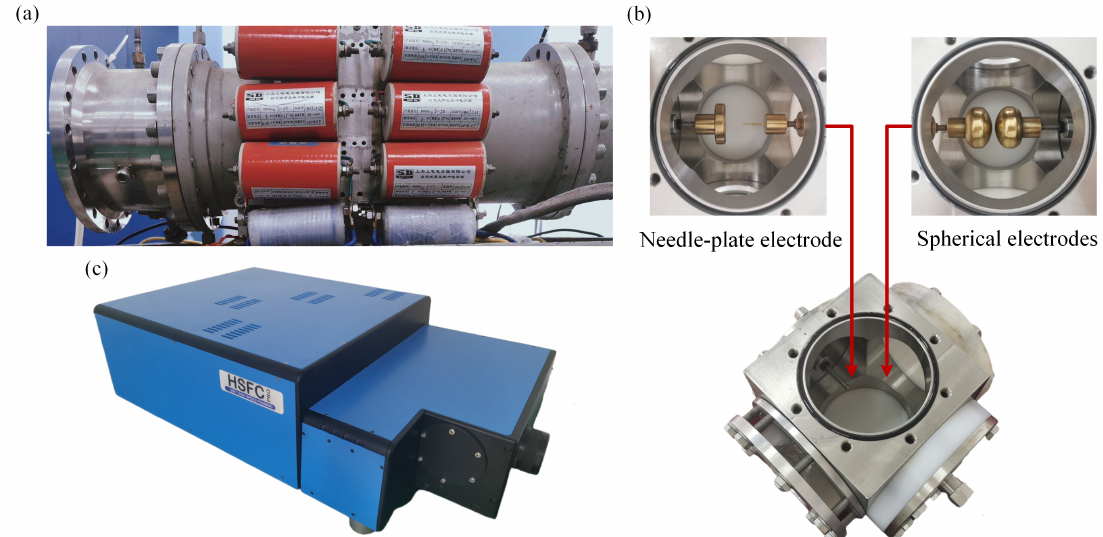
Figure 1. Experimental equipments of the microsecond-pulse breakdown strength test platforms: ( a ) microsecond pulse generator, ( b ) breakdown test cell, and ( c ) HSFC-pro high-speed